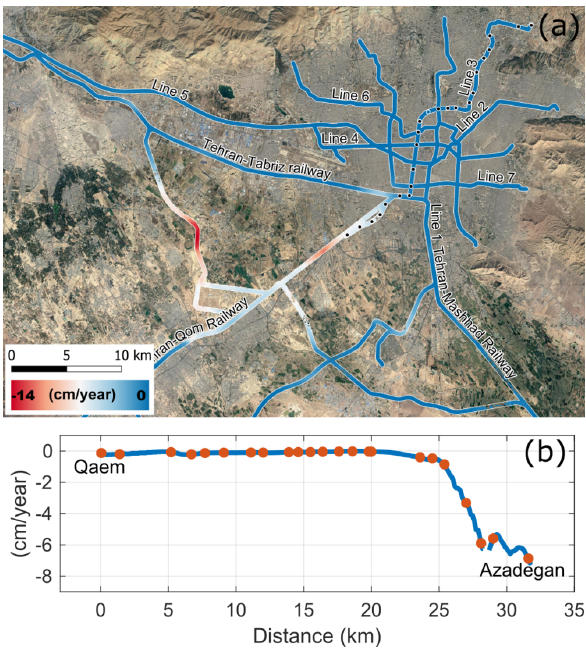
Figure 5. High-resolution analysis of subsidence for monitoring railways and metro lines in Tehran. (a) average rate of subsidence along railways and metro lines. Black circles indicate stations along metro line 3. (b) profile of displacement rate along metro line 3 from Qaem station in the northeast to Azadegan station in the southwest. Circles indicate metro stations. Background imagery for (a) Google Earth Landsat/Copernicus, Map data ©2021